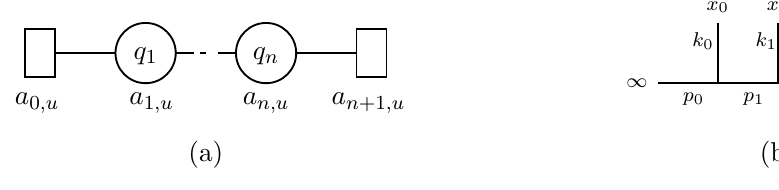
Figure 1 . (a) The diagram for the linear quiver U(2) n gauge theory. (b) The AGT dual conformal n + 3 -point block of the Toda field